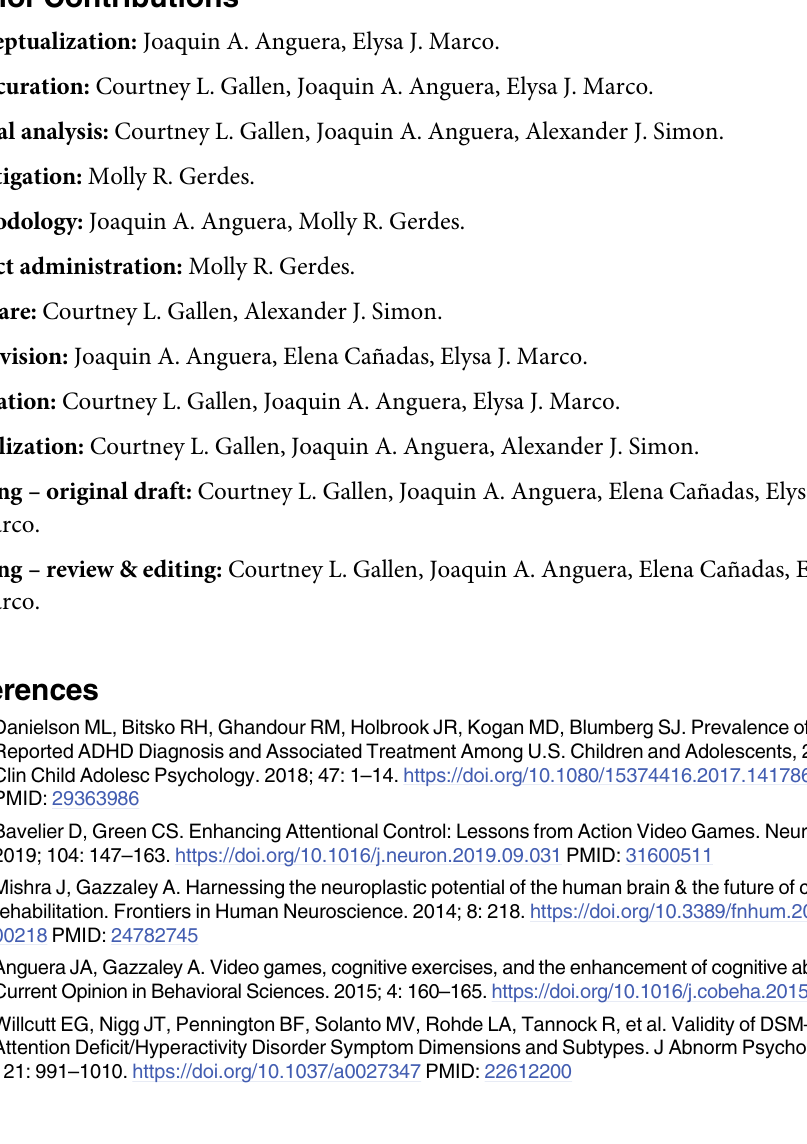
S1 Protocol. Study protocol developed by investigators and study sponsor (Akili Interac- tive,